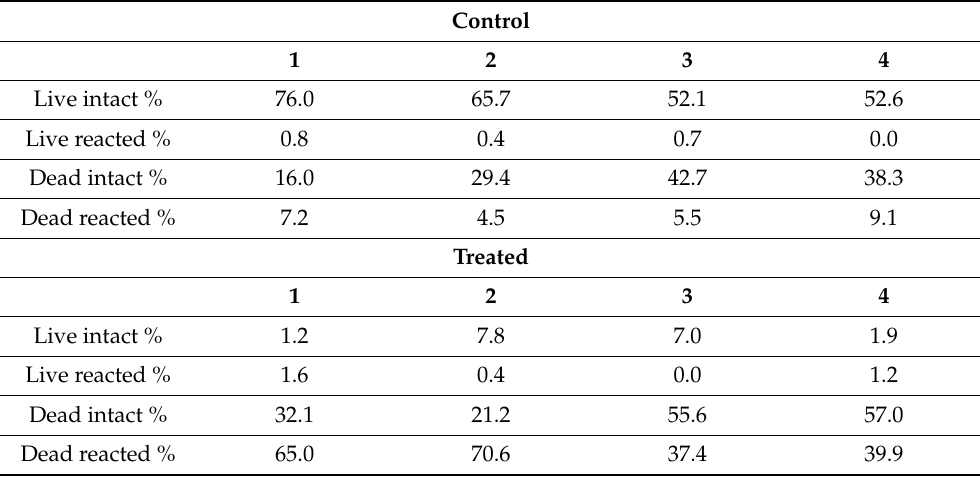
Figure 2. Example image of acrosome staining. No fluorescence indicates live intact spermatozoa (LI). Only bright red fluorescence indicates dead intact spermatozoa (DI). Bright red and green fluorescence indicates dead reacted spermatozoa (DR). Table 1. Live intact, live reacted, dead intact and dead reacted cells of acrosome and PI staining per sample.